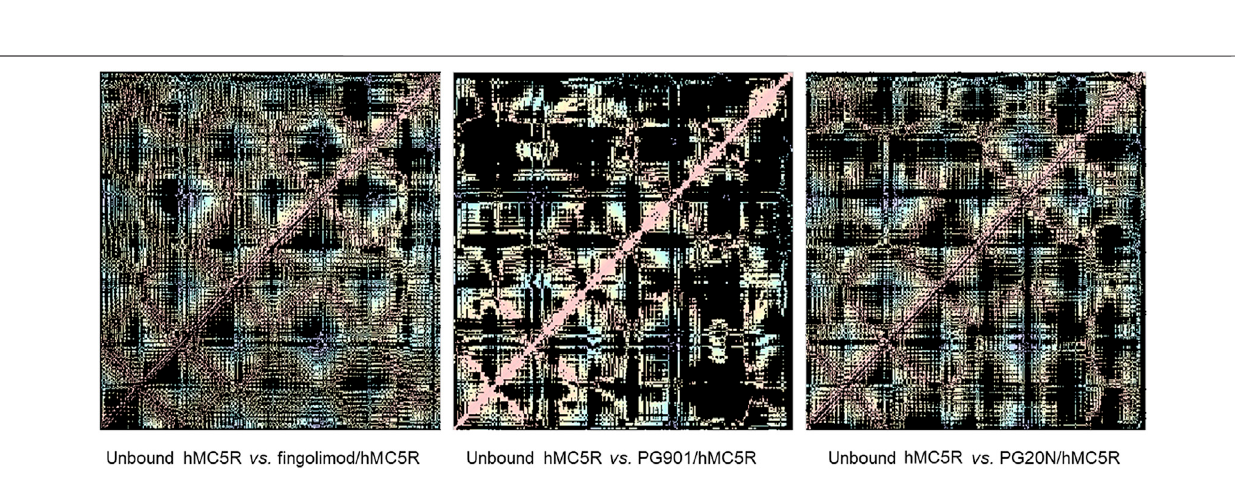
Frontiers in Pharmacology |